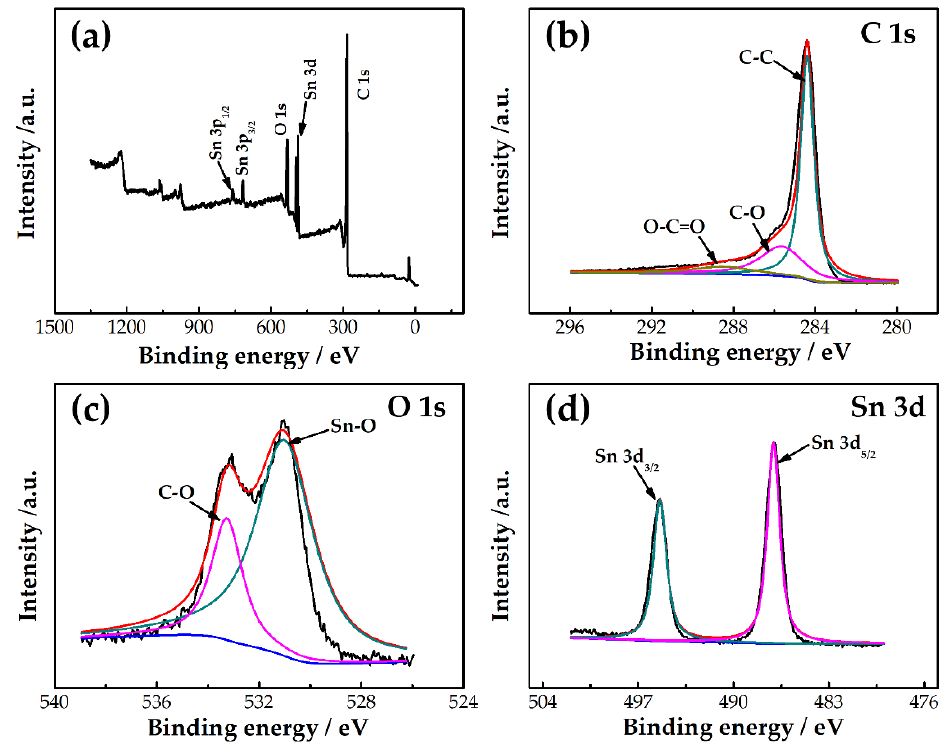
Figure 4. ( a ) XPS spectra of SnO 2 /rGO, and the high-resolution XPS spectra of ( b ) C 1s, ( c ) O 1s, and ( d ) Sn 3d. ( d ) Sn